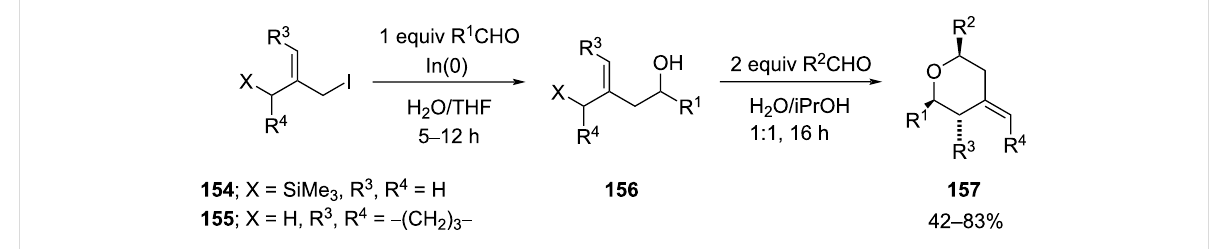
Scheme 37: Minehan and co-workers’ strategy for the synthesis of THPs 157 .